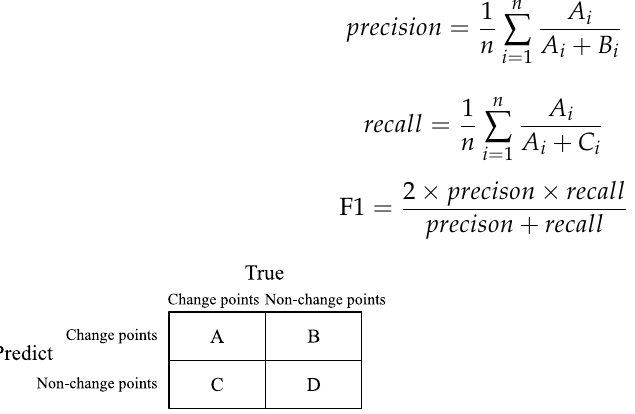
Figure 3. Schematic diagram of confusion matrix of change detection